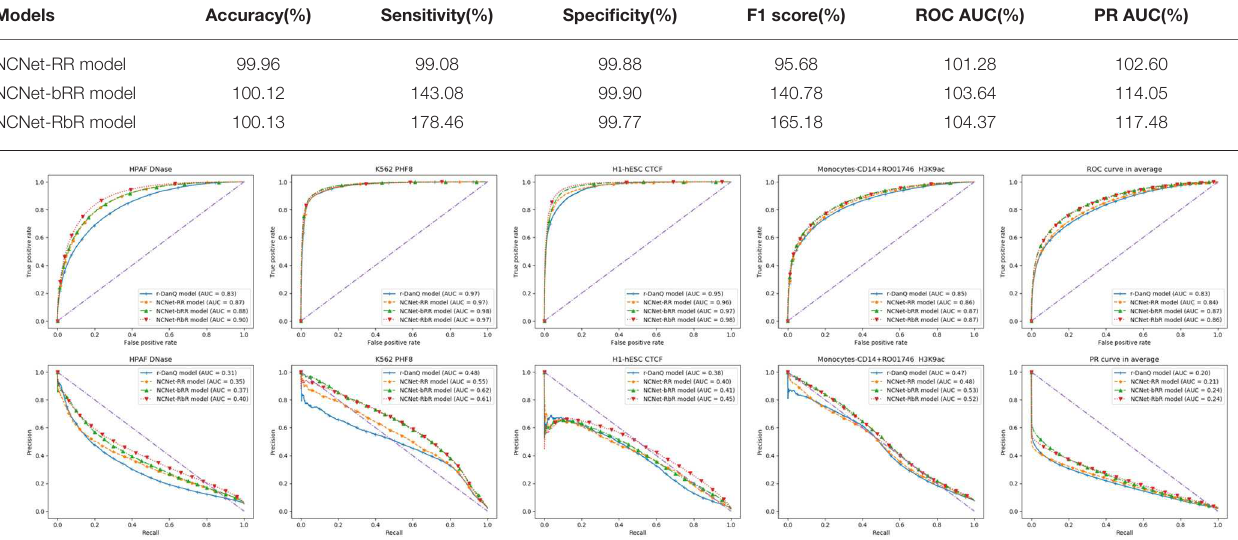
FIGURE 5 | Four typical target TF binding’s ROC (Up) and PR (Down) curves, with the mean ROC and PR curves (in the last column).